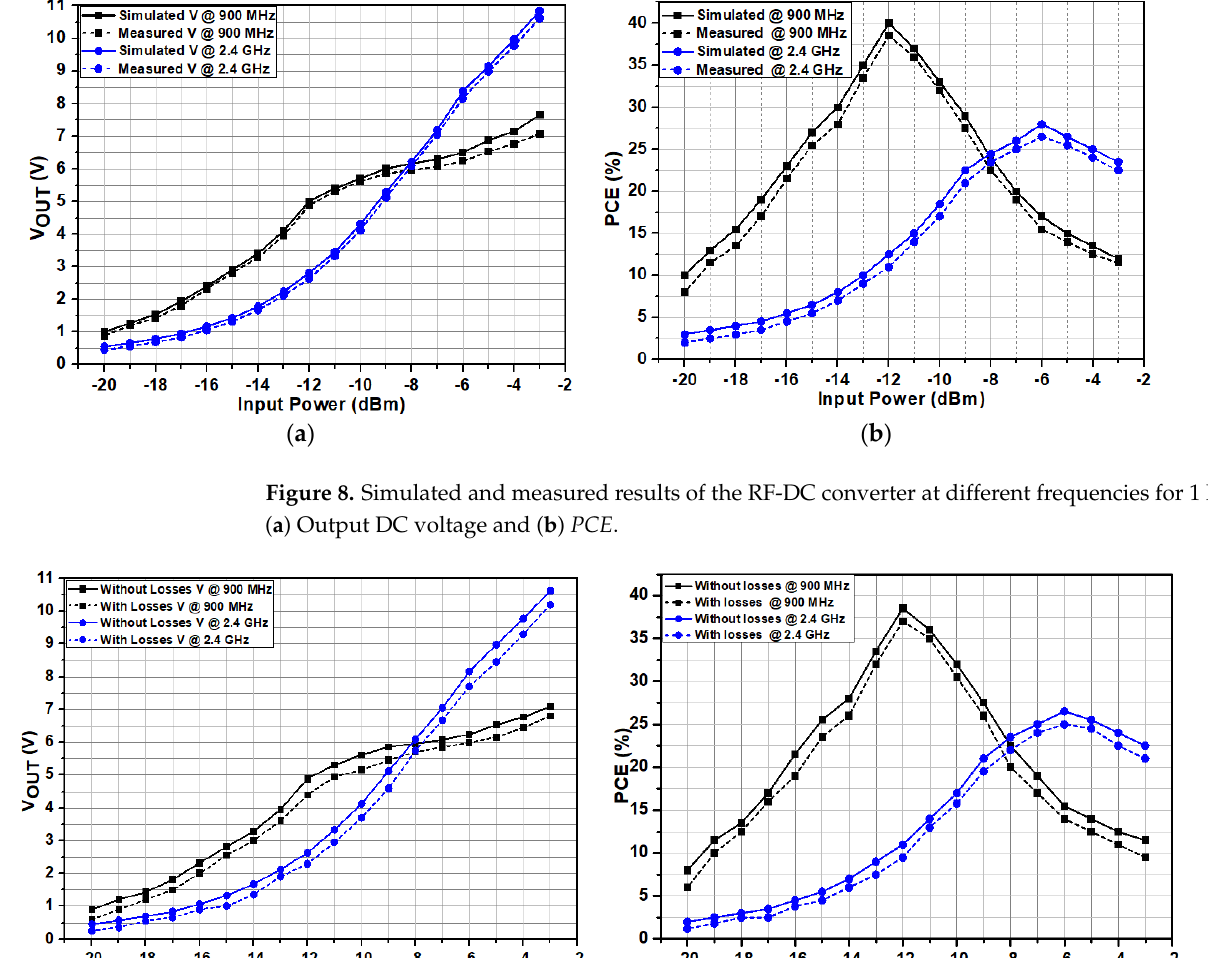
( b ) Figure 7. Simulated and measured results of the RF-DC converter for different loads. ( a ) Output DC voltage and ( b ) PCE . Similarly, a simulated efficiency of 40% and measured efficiency of 38% is achieved at − 12 dBm of the input power level at 1 M Ω load resistance. If the load resistance in- creases, the efficiency curve shifts towards the left side. The performance of the proposed RF-DC converter was checked in all PVT variations (typical corner points, slow corner points, and fast corner points) and compared with the measurement results. The performance was first checked on simulation and post-simulation levels for PVT variations and then measurement level. The proposed RF-DC converter satis- fied both the simulation and measurement results. Figure 8 shows simulated and measured results of the RF-DC converter at different frequencies, i.e., 900 MHz and 2.4 GHz. Figure 8a presents the simulated and measured DC voltage at both 900 MHz and 2.4 GHz frequencies. The recorded simulated and measured output DC voltage is 5 and 4.8 V, respectively, at − 12